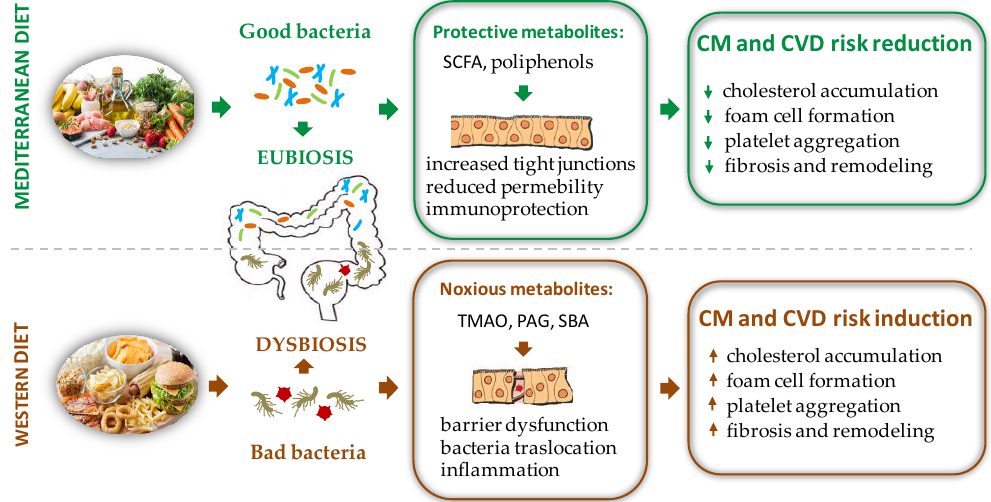
Figure 1. Schematic representation of the effects of different diet regimens on gut microbiota composition with opposite repercussions on CM and CVD risk factors. PAG = phenyl-acetylglutamine, SBA = secondary bile acids, SCFA = short chain fatty acid, TMAO = trimethylamine N-oxide.